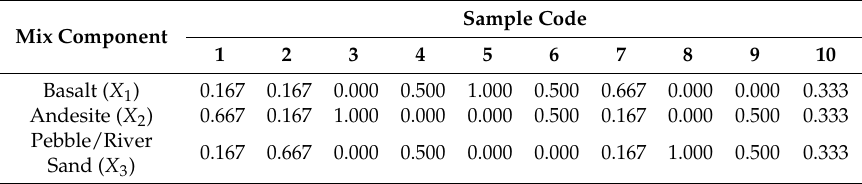
Table 3. Experimental proportion design for the [3, 2] simplex lattice design (SLD). Mix Component